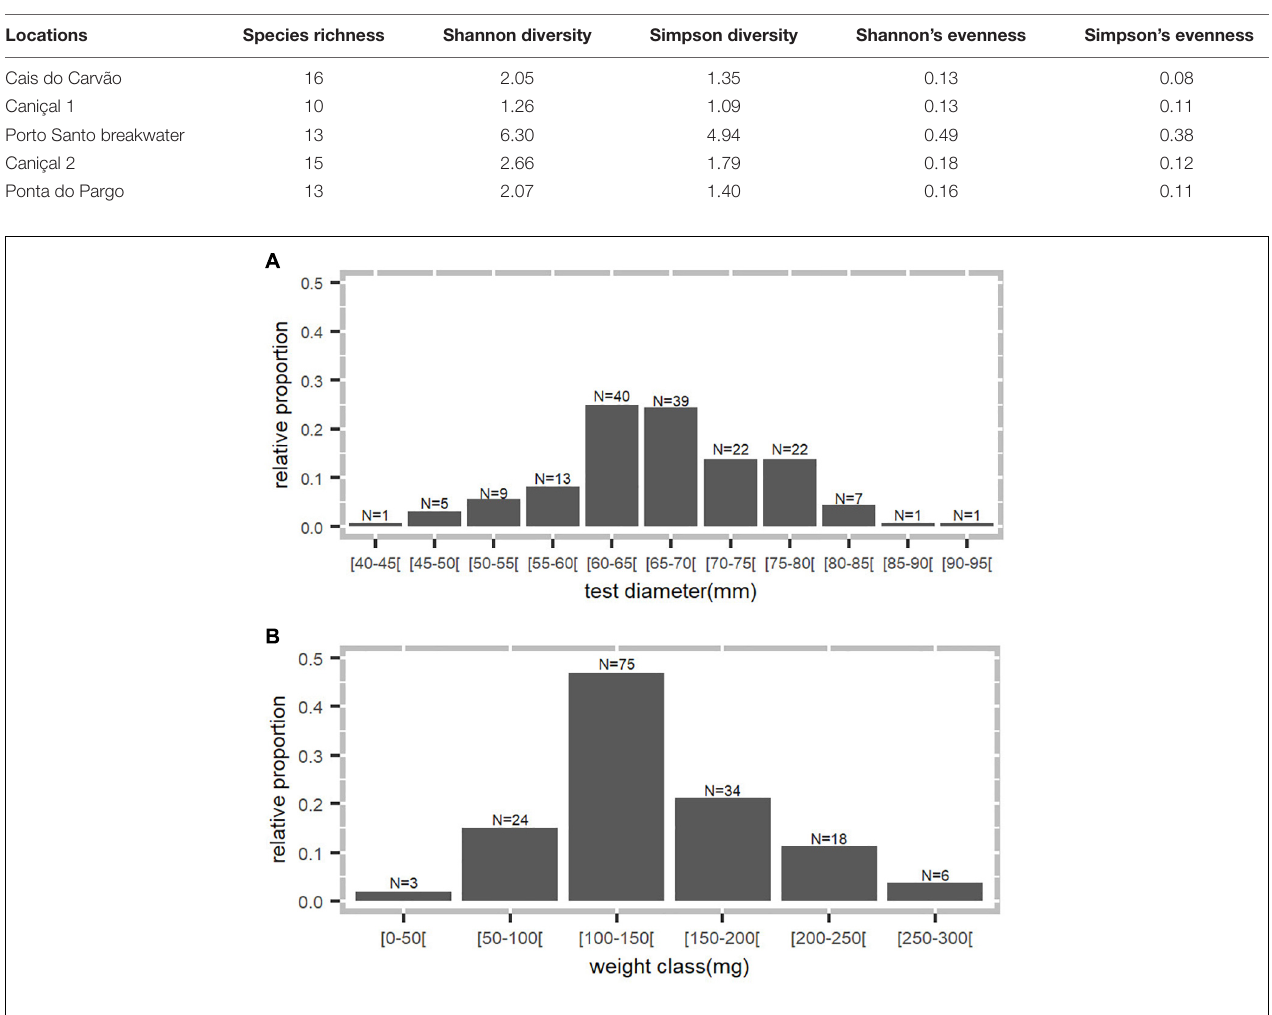
FIGURE 3 | Test diameter distribution [TD, (A) ], body weight distribution [BW, (B) ] of Sphaerechinus granularis samples collected in Madeira archipelago.